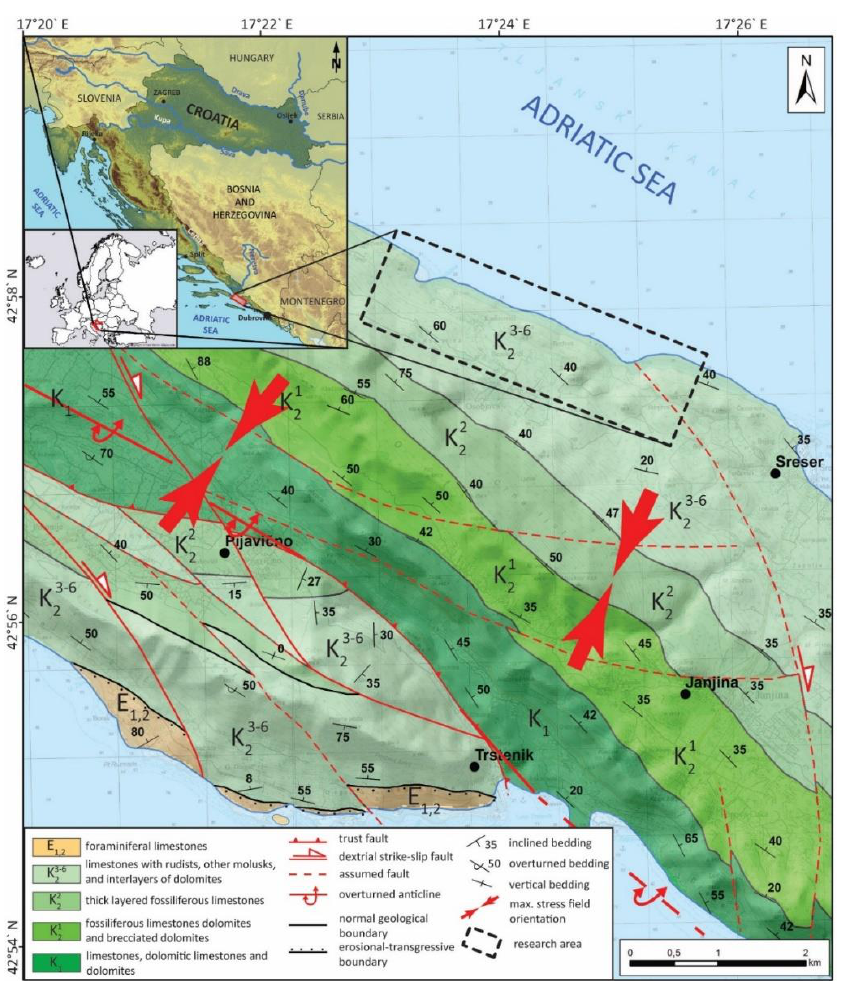
Figure 1. Geological map of the research area (modified after [26]). Stress orientation according to [20,27].